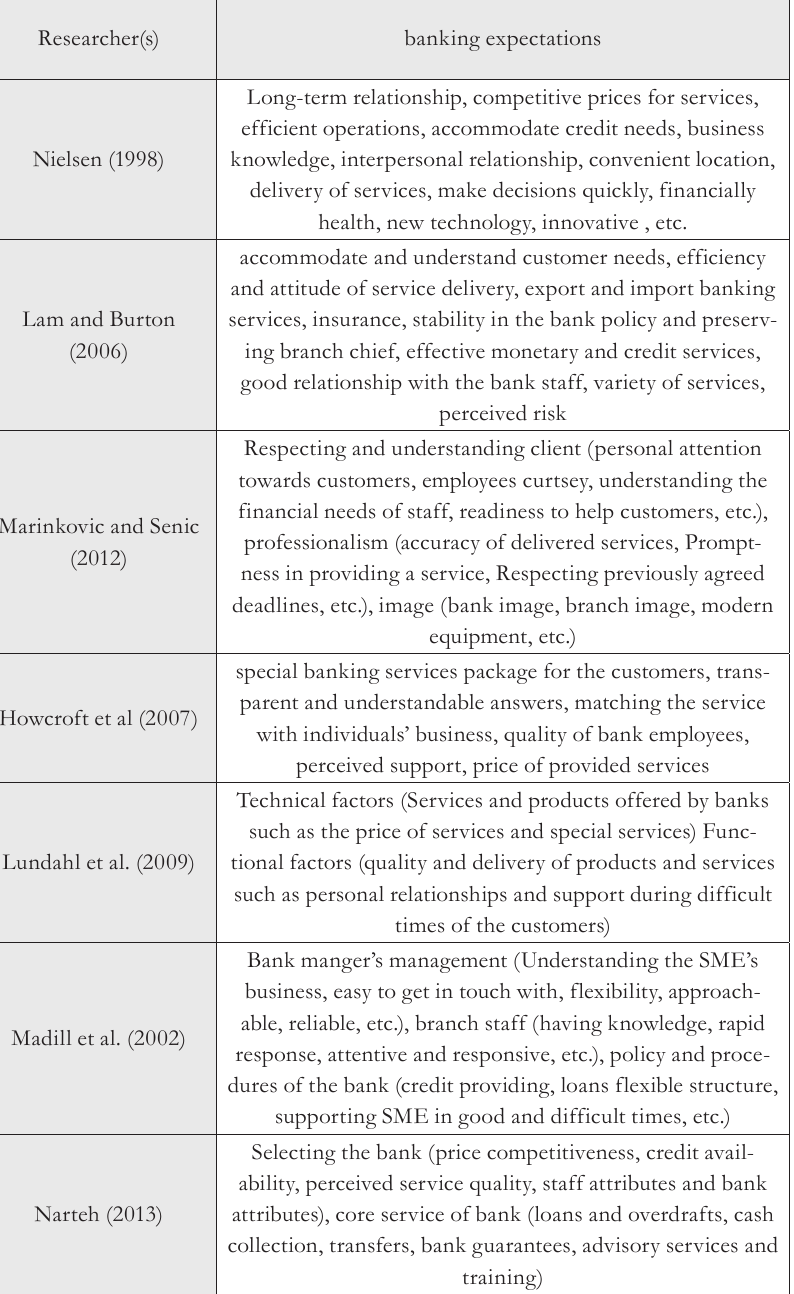
Tab. 2 - Expectations identified in past studies. (Source: